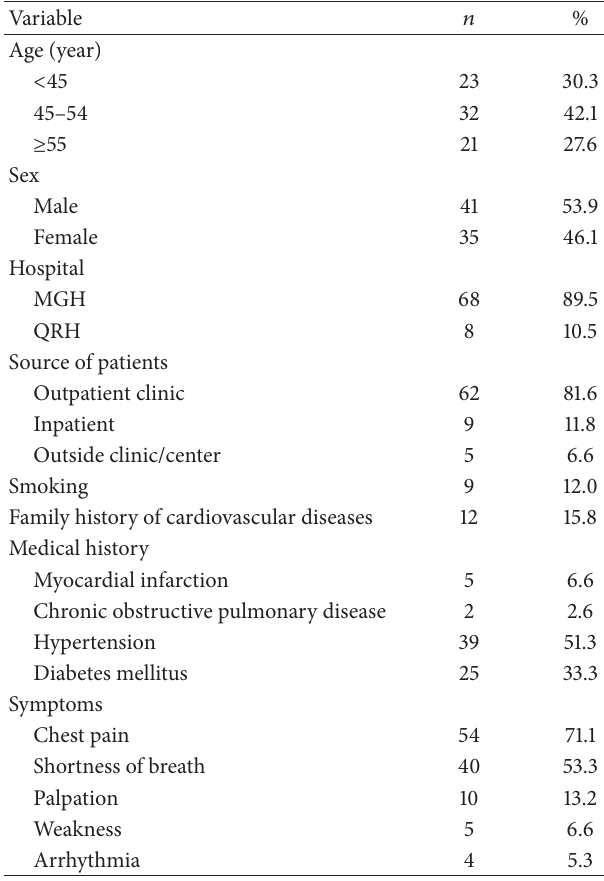
Table 1: The characteristics of patients who attended the telecardi- ology clinics in Mafraq Governmental Hospital (MGH) and Queen Rania Hospital (QRH) between September 2013 and January